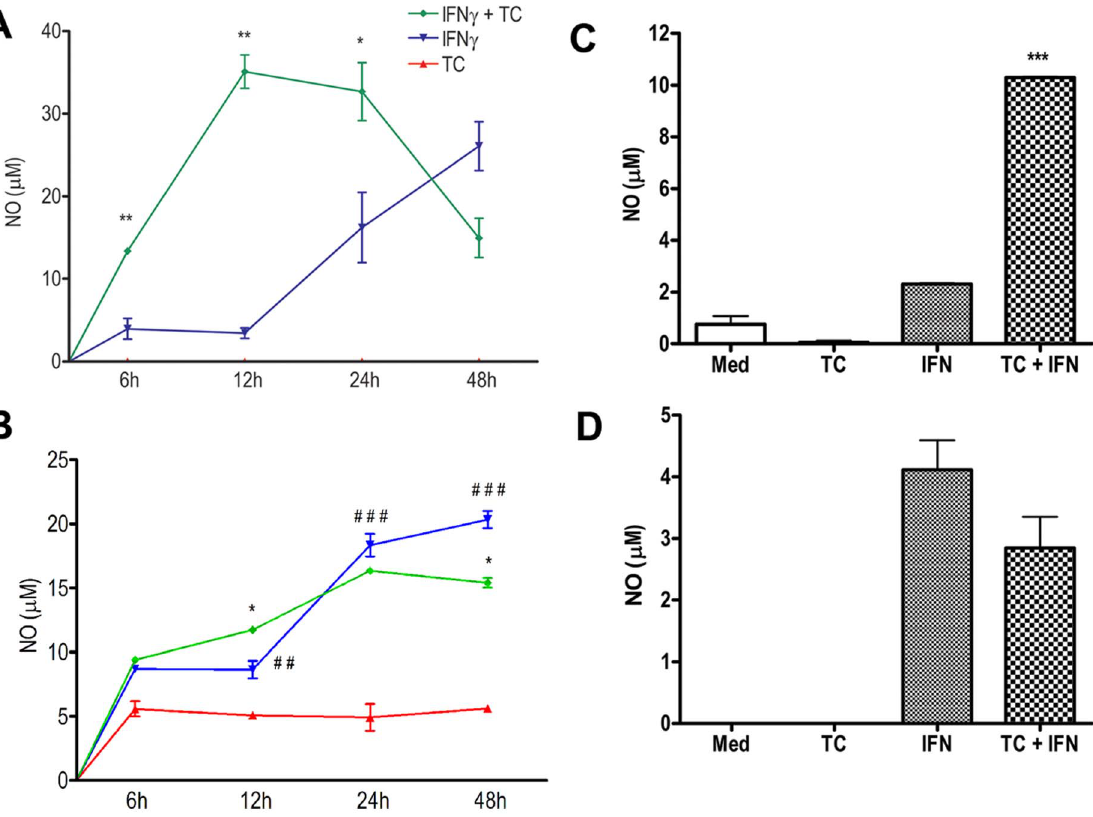
Figure 1. T.congolense augments IFN- c -induced NO release in immortalized and primary bone-marrow derived macrophages from relatively resistant C57BL/6 mice. Macrophage cell lines from (A) relatively resistant (ANA-1) and (B) highly susceptible (BALB.BM) mice were serum-deprived for 24 h followed by stimulation with IFN- c and TC WCE in combination or alone at indicated times. In some experiments, primary BMDM from (C) relatively resistant C57BL/6 and (D) highly susceptible BALB/c mice were similarly stimulation for 24 h. Supernatants were collected, centrifuged to remove cellular debris, and NO release was measured by Greiss’ Reaction. Data presented are representative of 5 different experiments with similar findings. *, p , 0.05; **, p , 0.01; and ***, p , 0.001 compared to respective IFN- c -stimulated controls; ## , p , 0.01; ### , p , 0.001 TC WCE + IFN c compared to TC WCE.